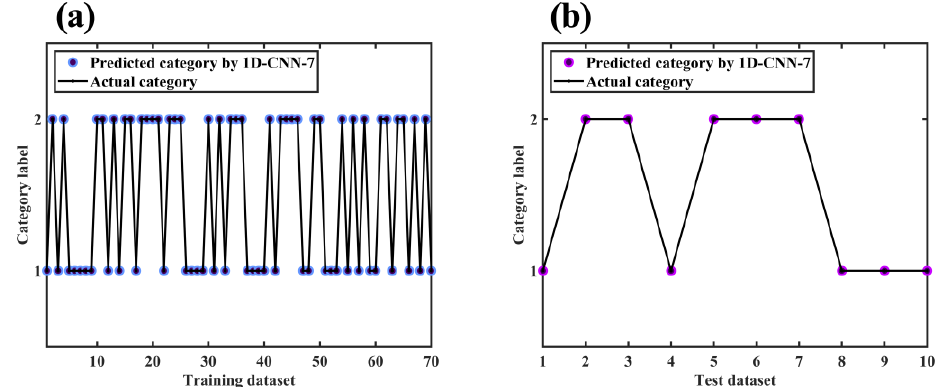
Figure 12. Classification results for ( a ) training dataset and ( b ) test dataset of 1D-CNN-7.